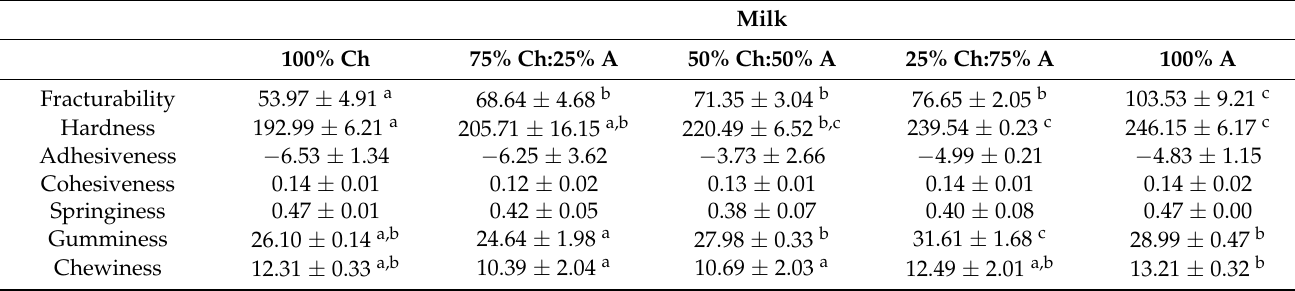
Table 4. Average values for texture parameters in Zamorano cheese made with milk from Churra (Ch) and Assaf (A) breed after 240 days’ ripening.